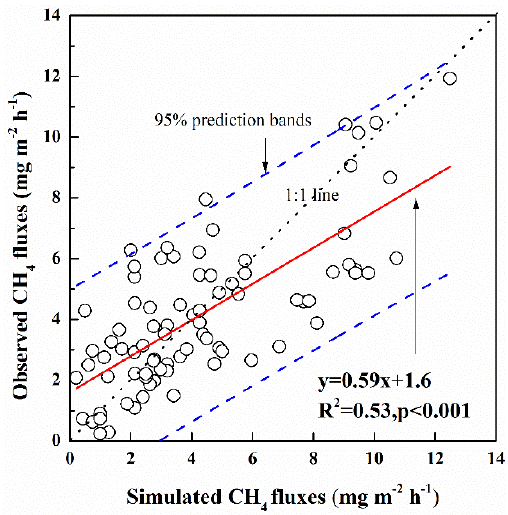
Figure 3. Comparison of observed and simulated CH 4 fluxes.